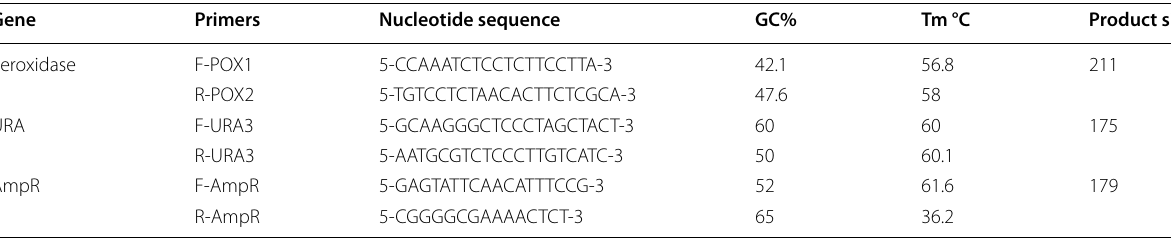
Table 1 DNA‑specific primers of the studied genes amplifications Gene Primers Nucleotide sequence